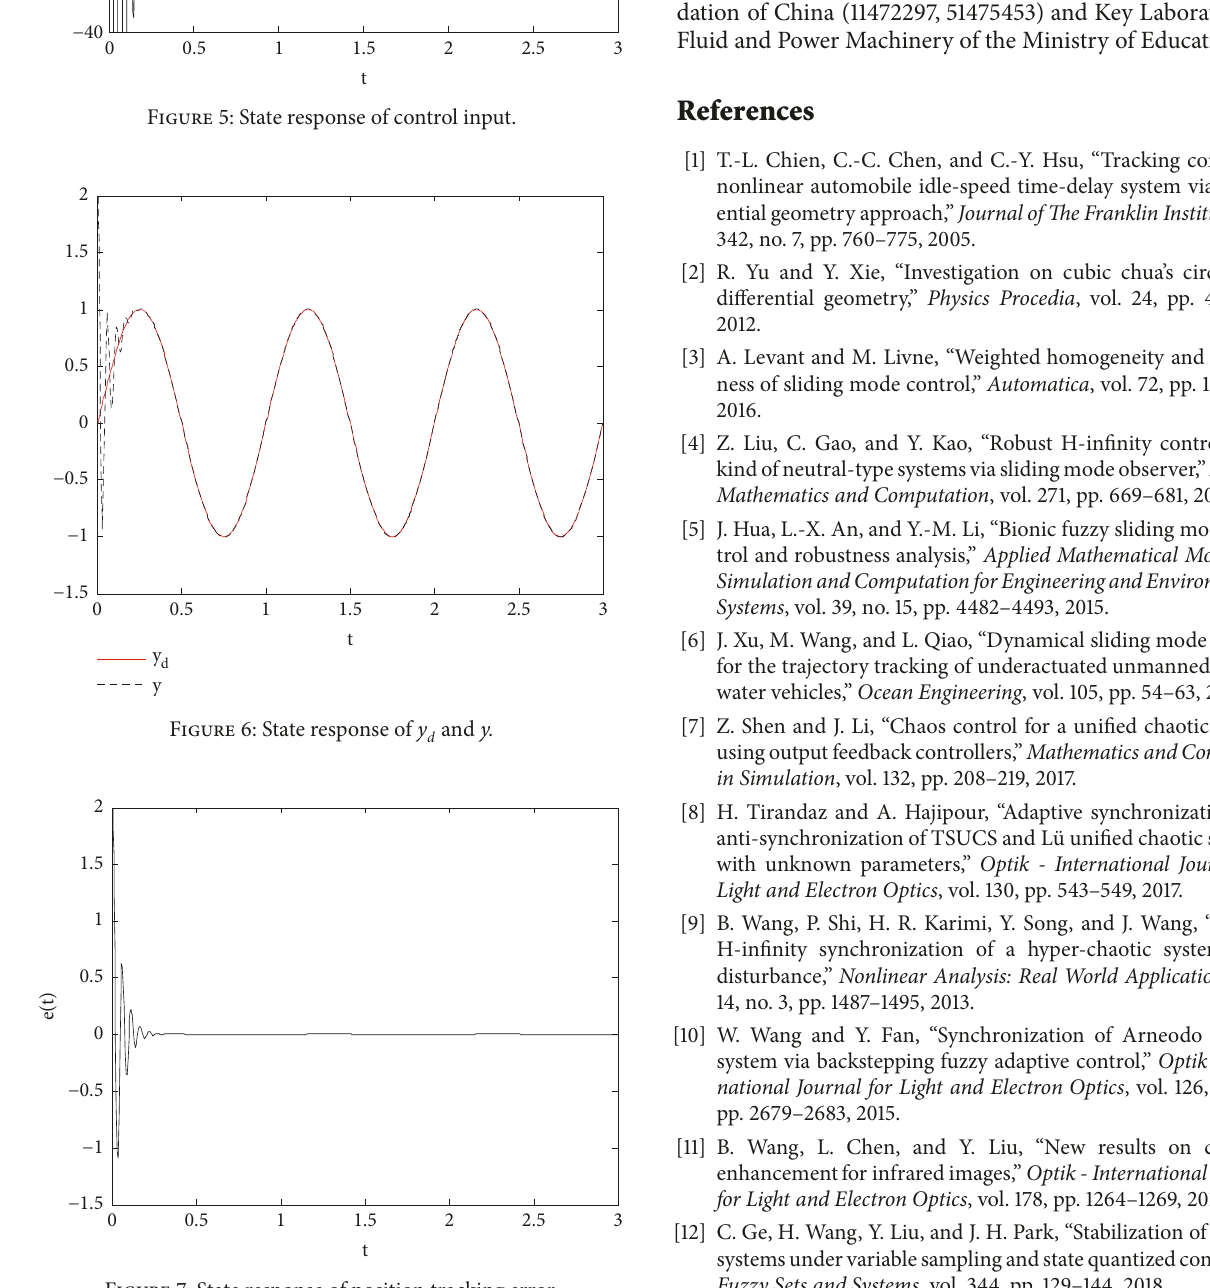
Figure 7: State response of position tracking